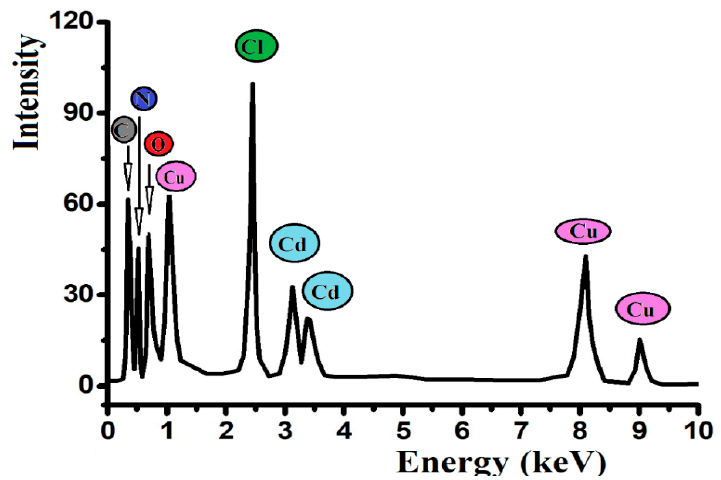
Figure 6. EDX spectra of the desired cluster.